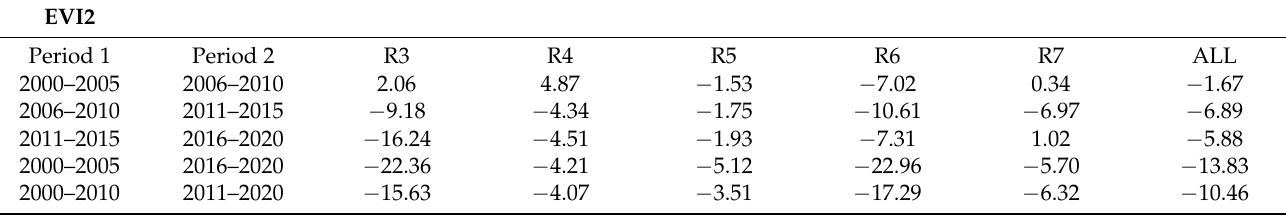
Table 1. The percent change in EVI2 for the peak growing season (averaged between 1 May and 30 October) between two periods with both positive and negative ( − ) directions of change provided for each reach and the full area, All reaches, in the riparian corridor of the Lower Colorado